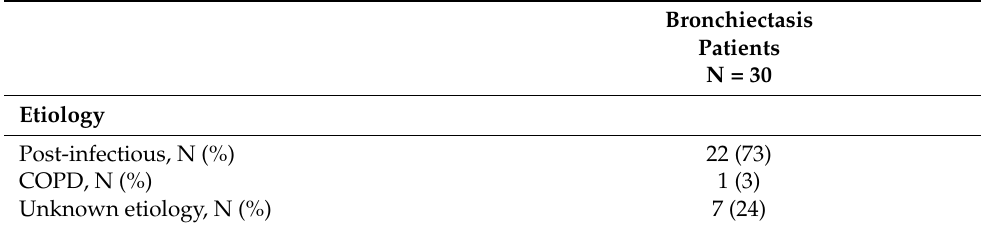
Table 3. Etiology of bronchiectasis in the study patients.